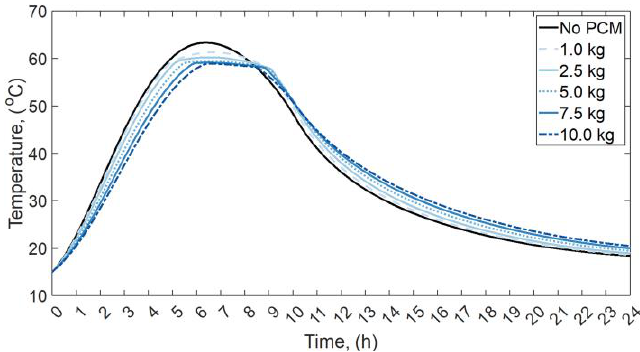
Figure 11. Water temperature in the SS with different masses of PCM — Case 1.